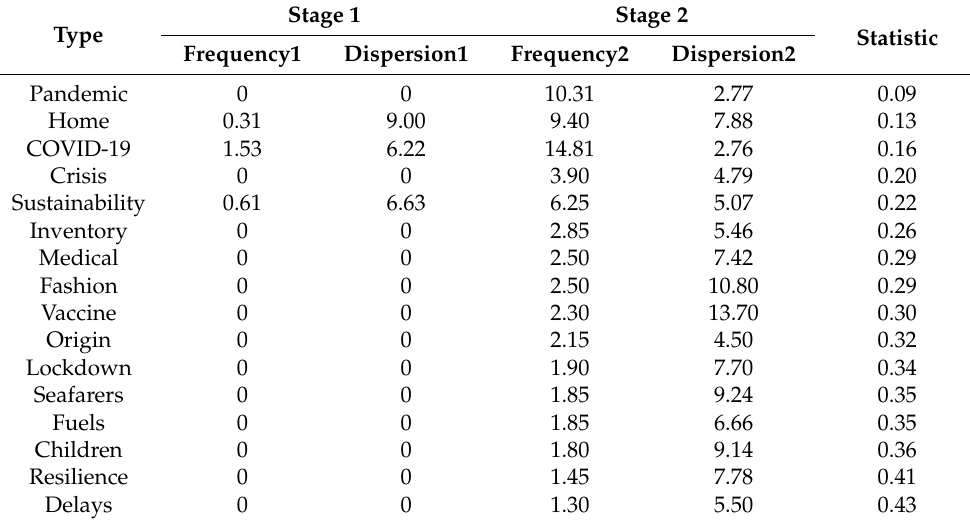
Table 5. Negative keywords for Stage 1 to Stage